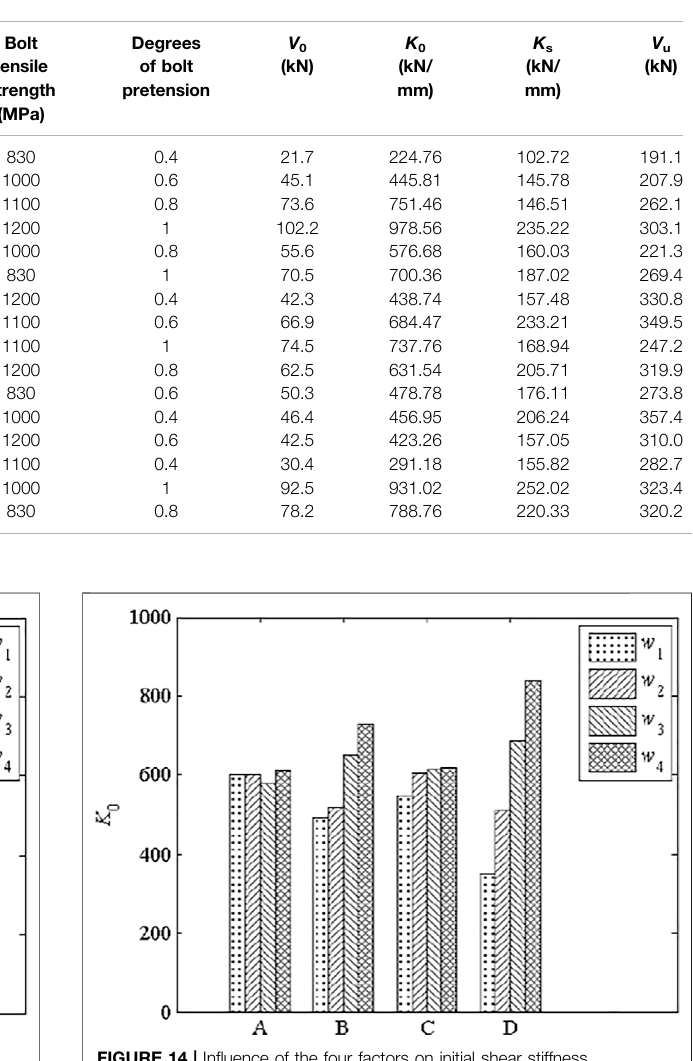
FIGURE 13 | In fl uence of the four factors on the initial slip force of HSFGBs.